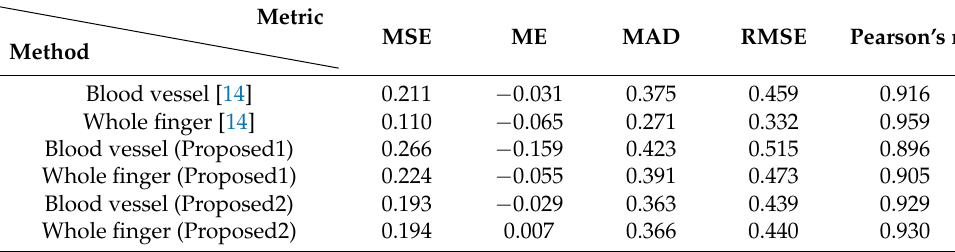
Table 4. HbA1c estimation performance comparison between this study and the previous study.